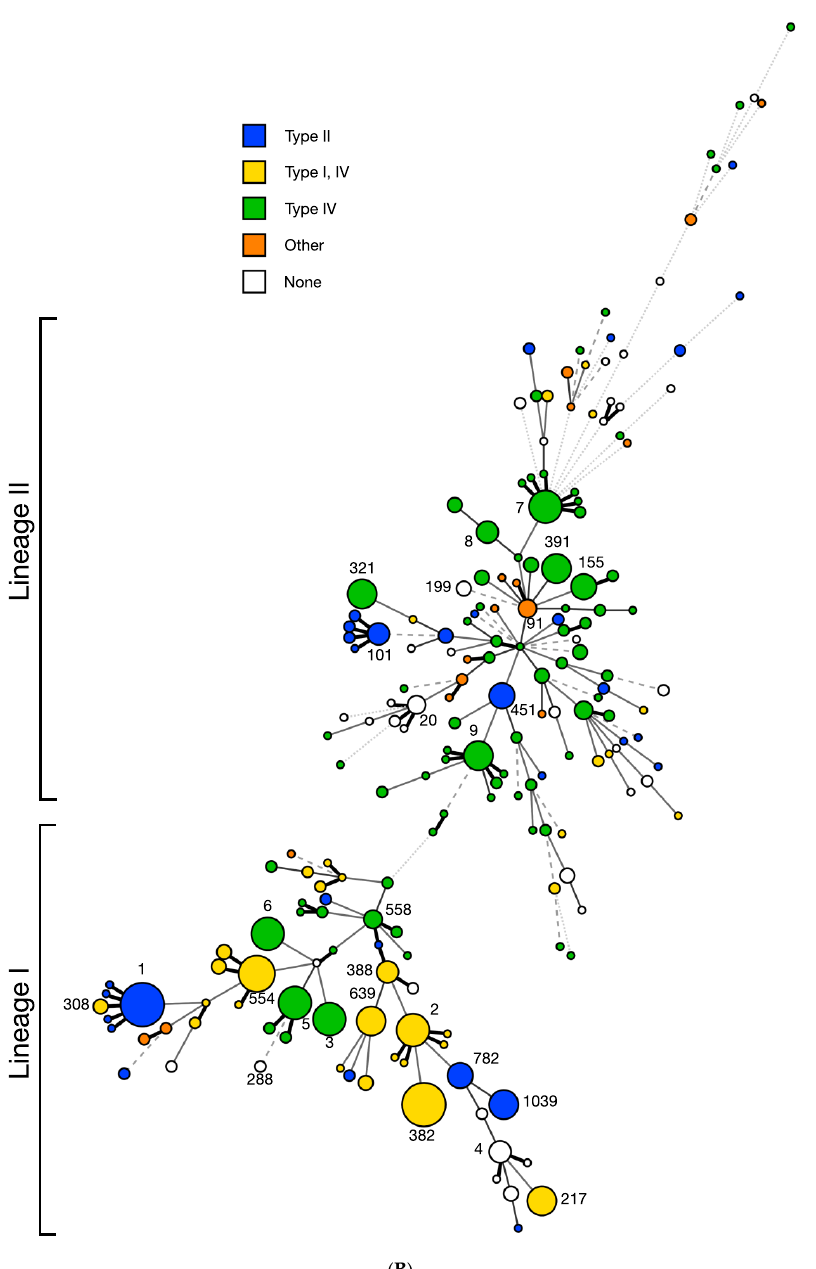
Figure 3. Distribution of restriction modification systems in the ICR in strains of diverse STs. Mini- mum spanning tree (MST) was constructed with the seven-locus MLST scheme using BioNumerics 8.1 as described in Materials and Methods. Each circle corresponds to a single sequence type (ST) and the circle size correlates to the number of strains in the respective ST; numbers next to circles denote relevant STs (e.g., 1, 2, 388, 1039). The smallest circles include one genome while the largest circle includes 50 genomes. STs are separated by branches based on seven-locus MLST similarity: one- allele difference (thick black line), two-allele differences (thin gray solid line), three-allele differences (dashed line), four-allele differences (dotted line), more than four-allele differences (thin dotted line). STs are color-coded based upon ( A ) serotype or lineage and ( B ) ICR content, specifically the harbored type of RM system(s). “Other” ICR content includes miscellaneous genomic islands and genes (e.g., DNA helicase genes), while “none” indicates no novel gene content, typically a lipoprotein and small hypothetical